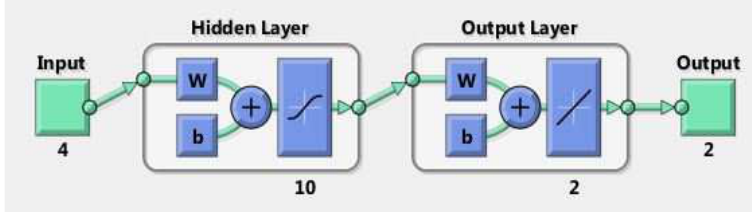
Figure 4. Architecture of the BPNN model for the best performance case.